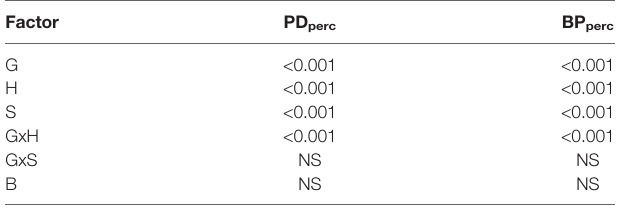
TABLE 5 | Signi fi cance of main effects of snap bean genotype (G), seed size (S) and herbicide dose (H), Block (B) and their interactions on response variables for genotypes Goldmine and Navarro and extra-large and extra small seed size